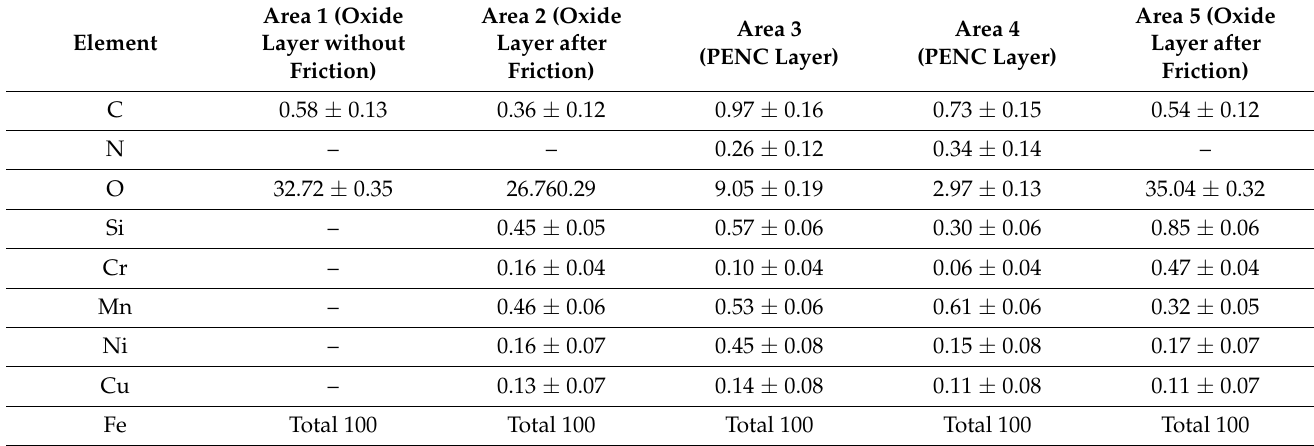
Table 4. Elemental composition (wt.%) of some areas of the friction track (Figure